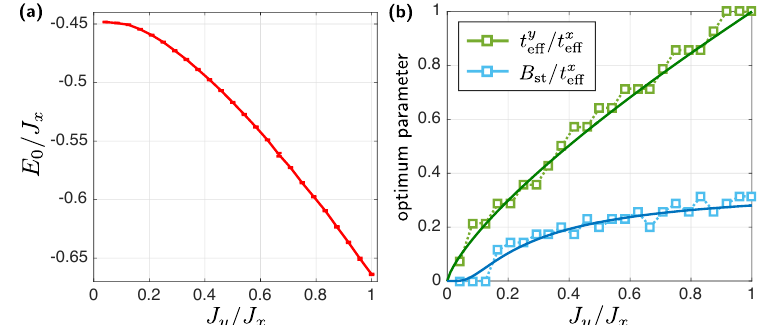
Figure 9: Spin-hole-spin correlations. The three-point function C z is calculated for different values of J from the meson trial wavefunction in Eq. (4) y = ( π/ 2, π/ 2 ) , Φ = π/ 2 for optimized B evaluated at k MP = 16, L = 8, S z = 1 / 2 and t = 3 J Parameters are L x y + A e − d /ξ which we used to extract the length scale ξ ( J of the form A 1 2